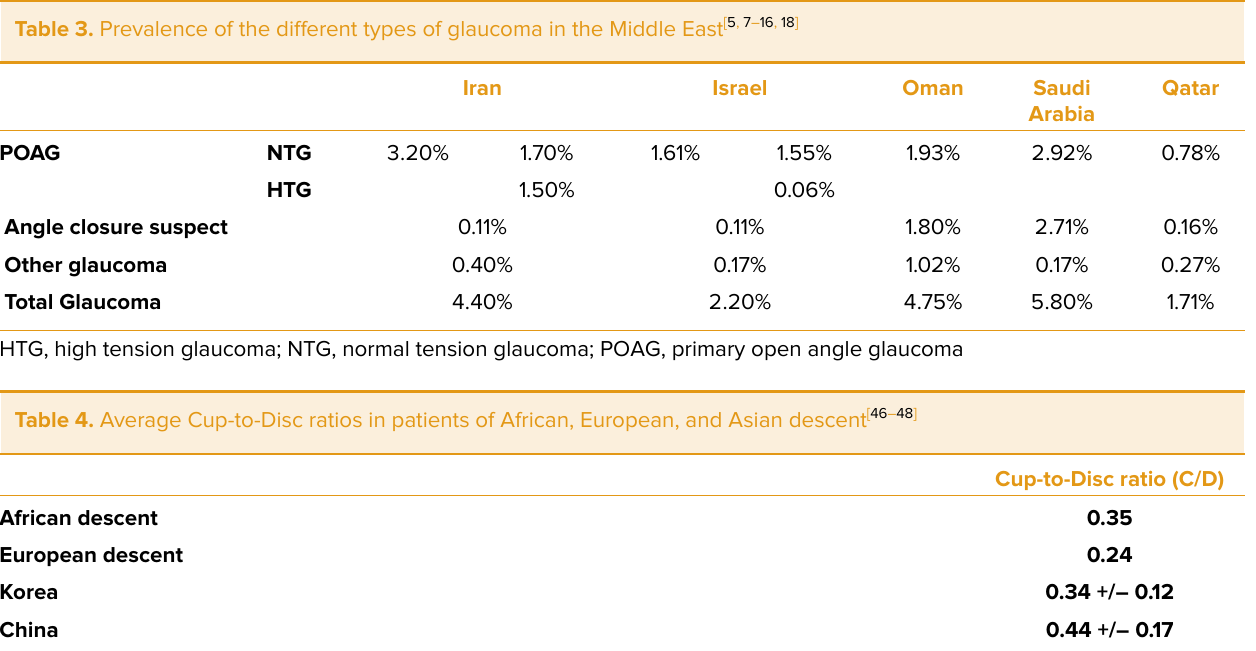
Table 3. Prevalence of the different types of glaucoma in the Middle East [5, 7–16, 18]